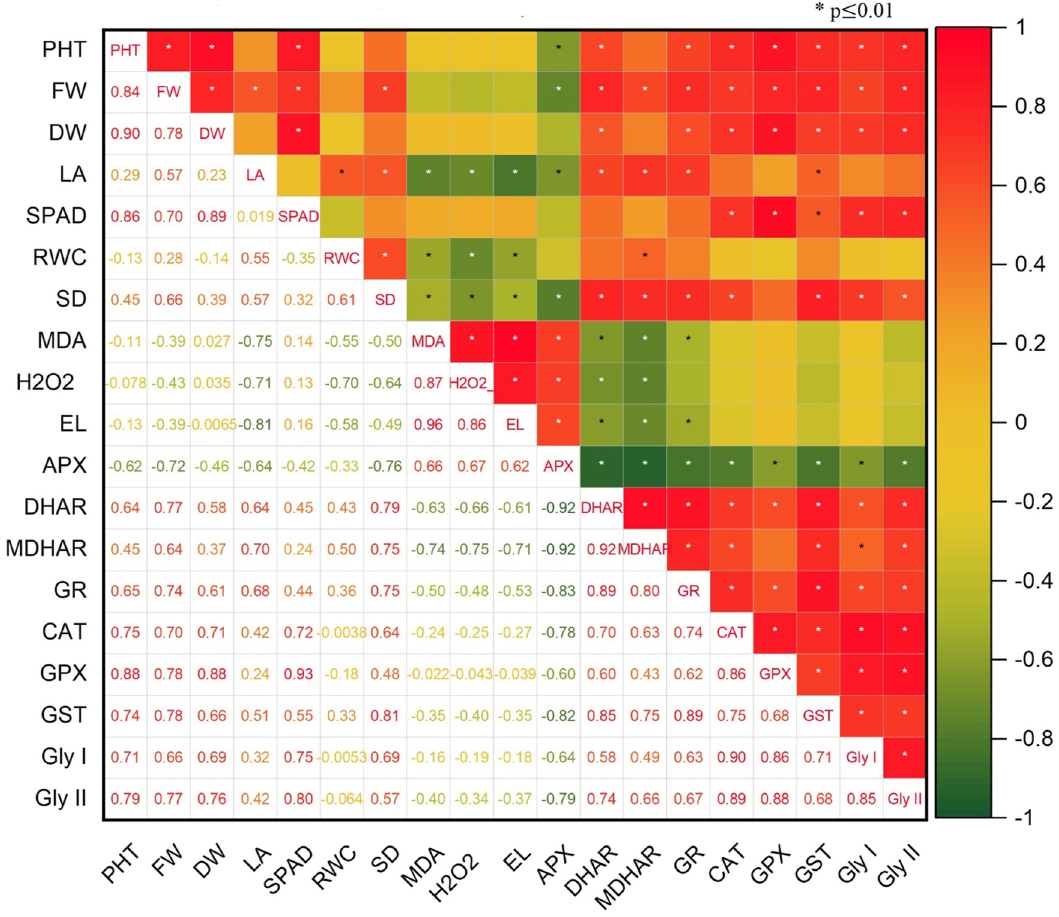
Figure 9: Correlation analysis of di ff erent studied parameters ( PHT – Plant height; LA – Leaf area; FW – Fresh weight; DW – Dry